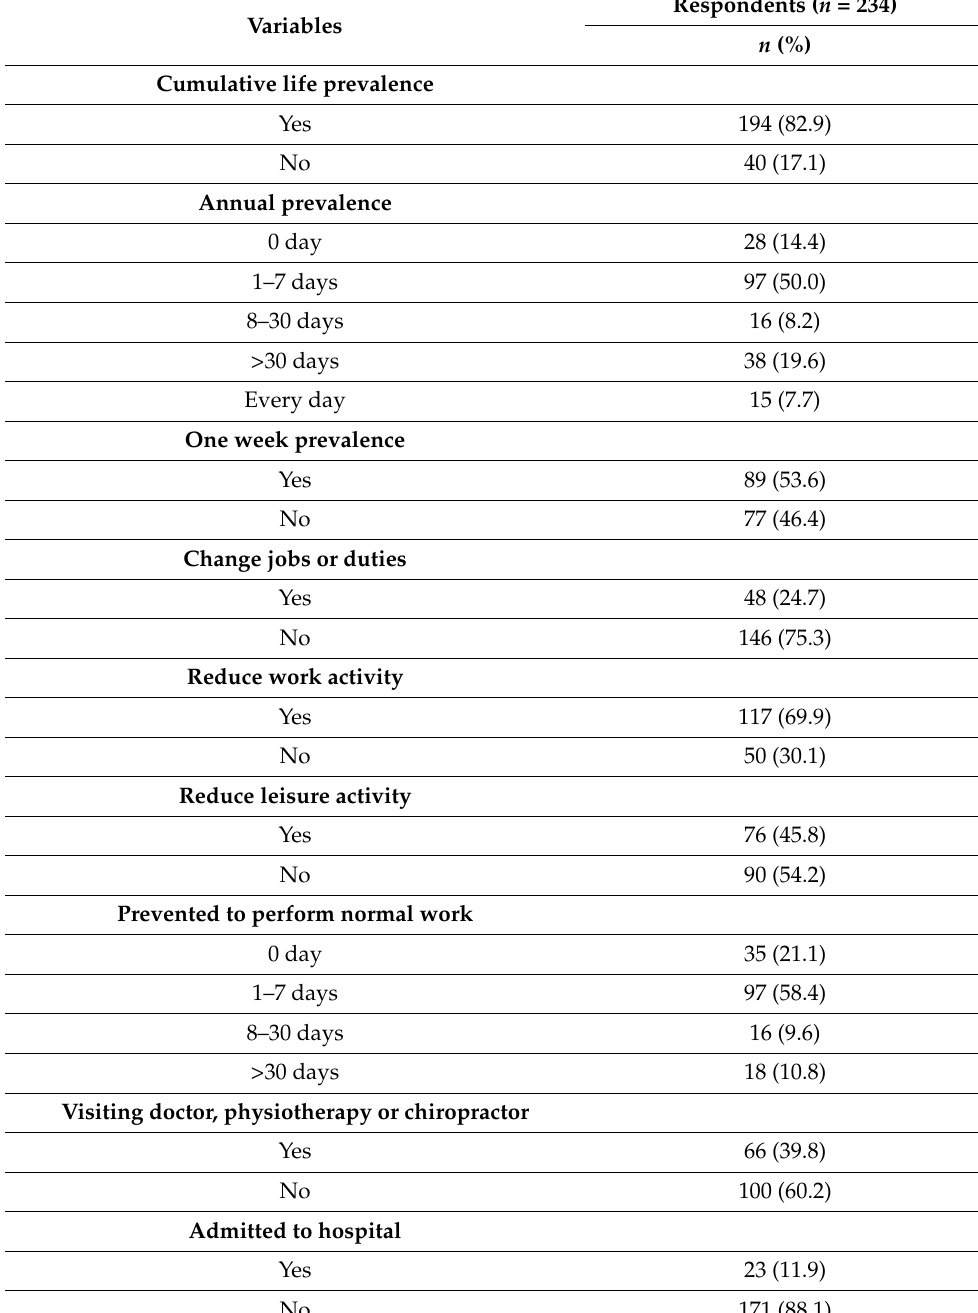
Table 4. Prevalence of LBP and its consequences among